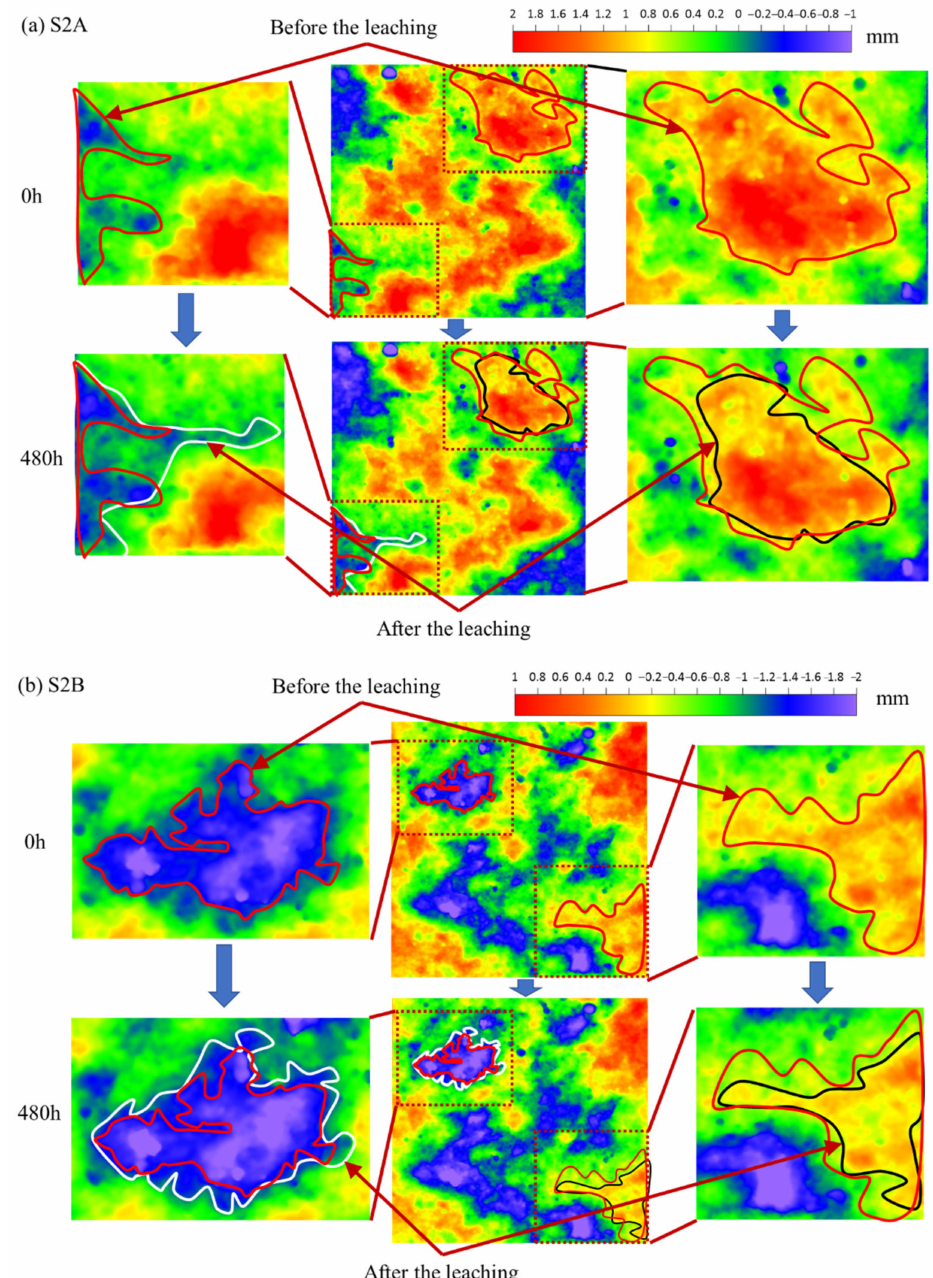
Figure 9. Temporal evolution in fracture surface geometry variation. Second, in order to further obtain the degraded depth of the fracture surface elevation and summarize the universal law, the elevation distributions of all fracture surfaces are shown in Figure 10, where, the black line indicates the distribution of elevation before the leaching experiment and the red line indicates the distribution after the leaching